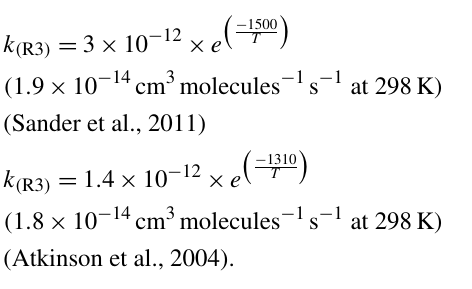
Figure 5. Residence time for NO 2 calibration gas in the calibra- tor based on Eq. (3). Also, theoretically calculated residence time (7.73s) is shown (red line). The likelihoods (green or blue shaded areas) of residence times based on the JPL or IUPAC rate constant for being accurate are indistinguishable in comparison to the theo- retically calculated residence